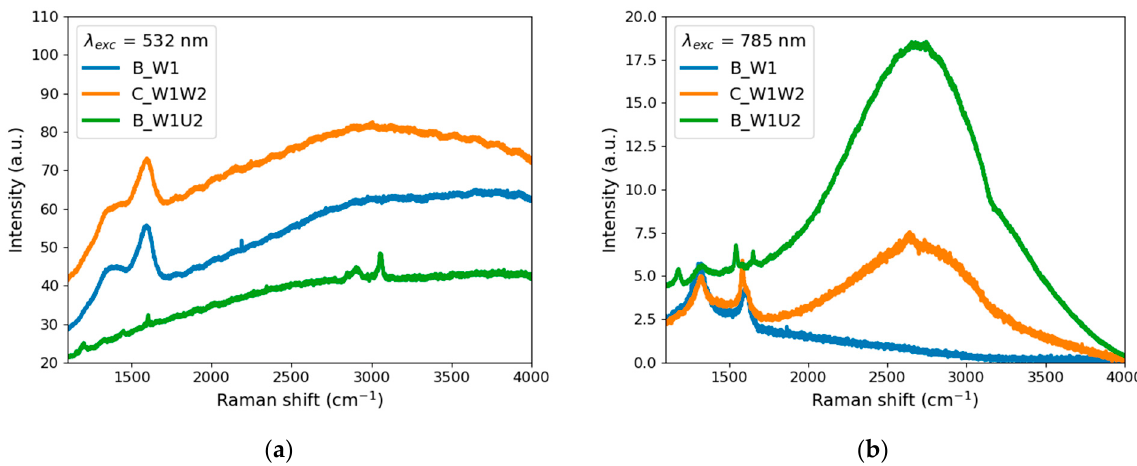
Figure 8. Raman spectra of Samples B_W1, C_W1W2, and B_W1U2 excited at ( a ) 532 nm (the B_W1U2 signal was multiplied by 2) and ( b ) 785 nm (the B_W1U2 signal was divided by 5).